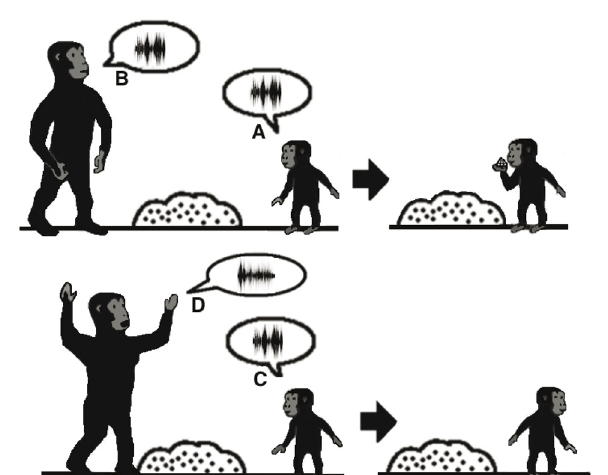
Figure 4. Prosody and the emergence of question-answer conversations. In accordance with the model, the modification of contact calls with intonations for reporting distress levels eventually transitioned into question-answer conversations about items in their environment. In this figure, a child is using low-level distress call ( A , C ) to ask permission to eat an unfamiliar food (berries). The mother can then respond with a high-level distress call ( D ) that signals danger or a low-level distress ( B ) that signals